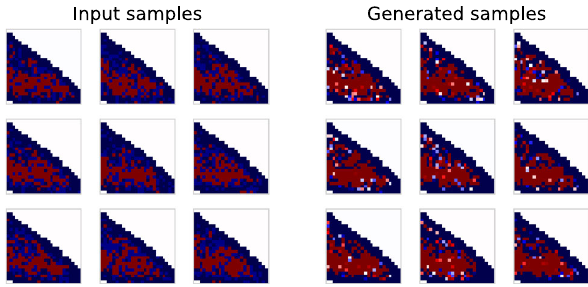
Fig. 6 A random selection of preprocessed input images (left), and of images generated with the LSGAN model (right). Axes and colour schemes are identical to Fig. 5